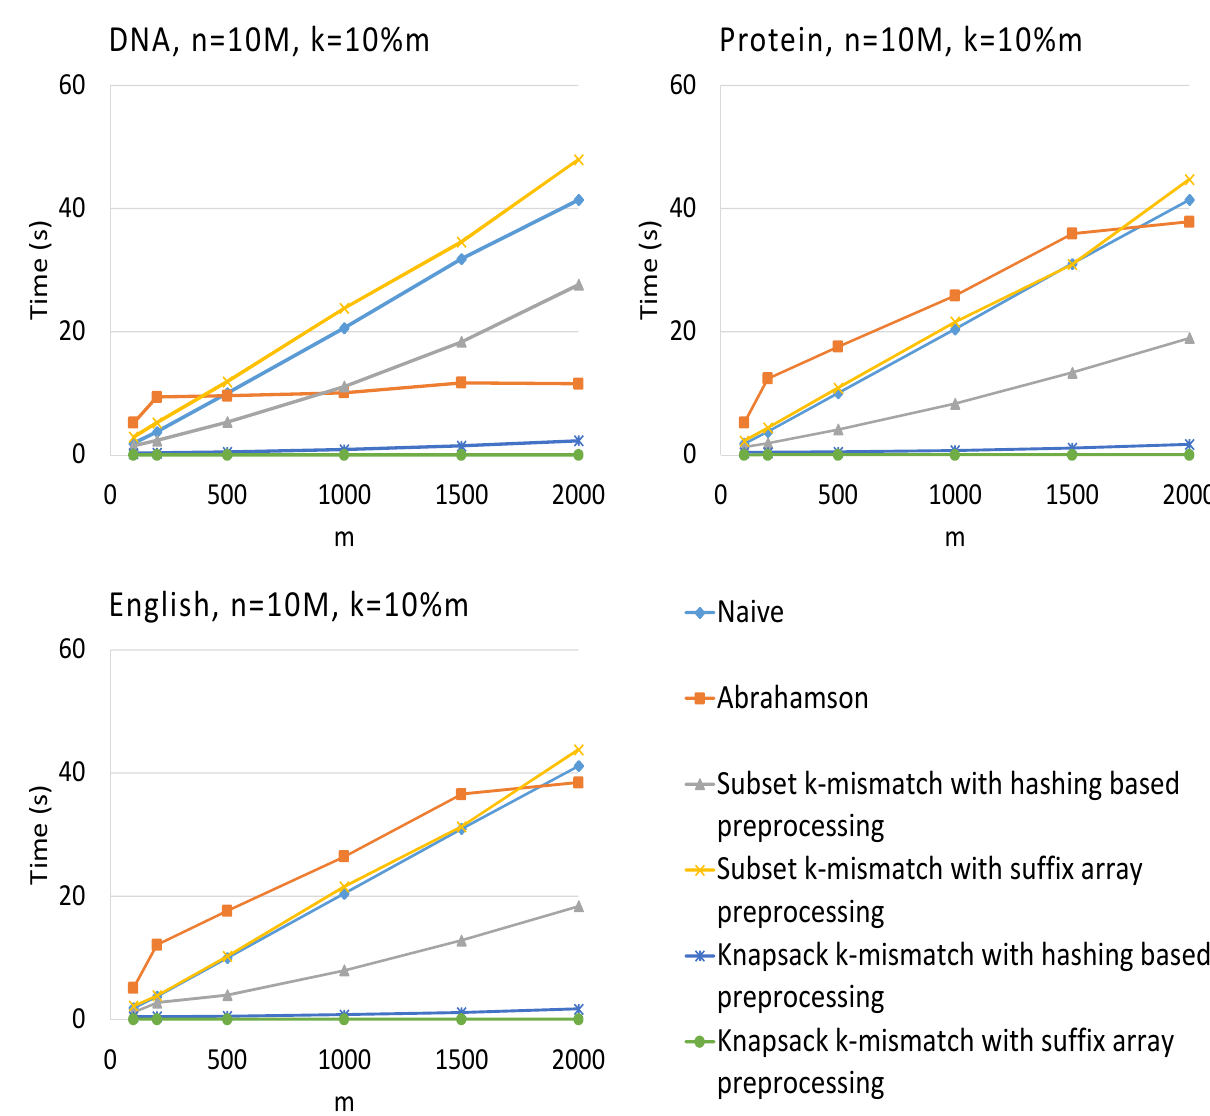
Figure 2. Run times for pattern matching on DNA, protein and English alphabet data, when the length of the pattern ( m ) varies. The length of the text is n = 10 millions. The maximum number of mismatches allowed is k = 10% of the pattern length. Our algorithms are subset k mismatch with hashing-based preprocessing (Section 2.2.2), subset k mismatch with suffix array preprocessing (Section 2.2.2), knapsack k mismatch with hashing-based preprocessing (Section 2.2.3) and knapsack k mismatch with suffix array preprocessing (Section